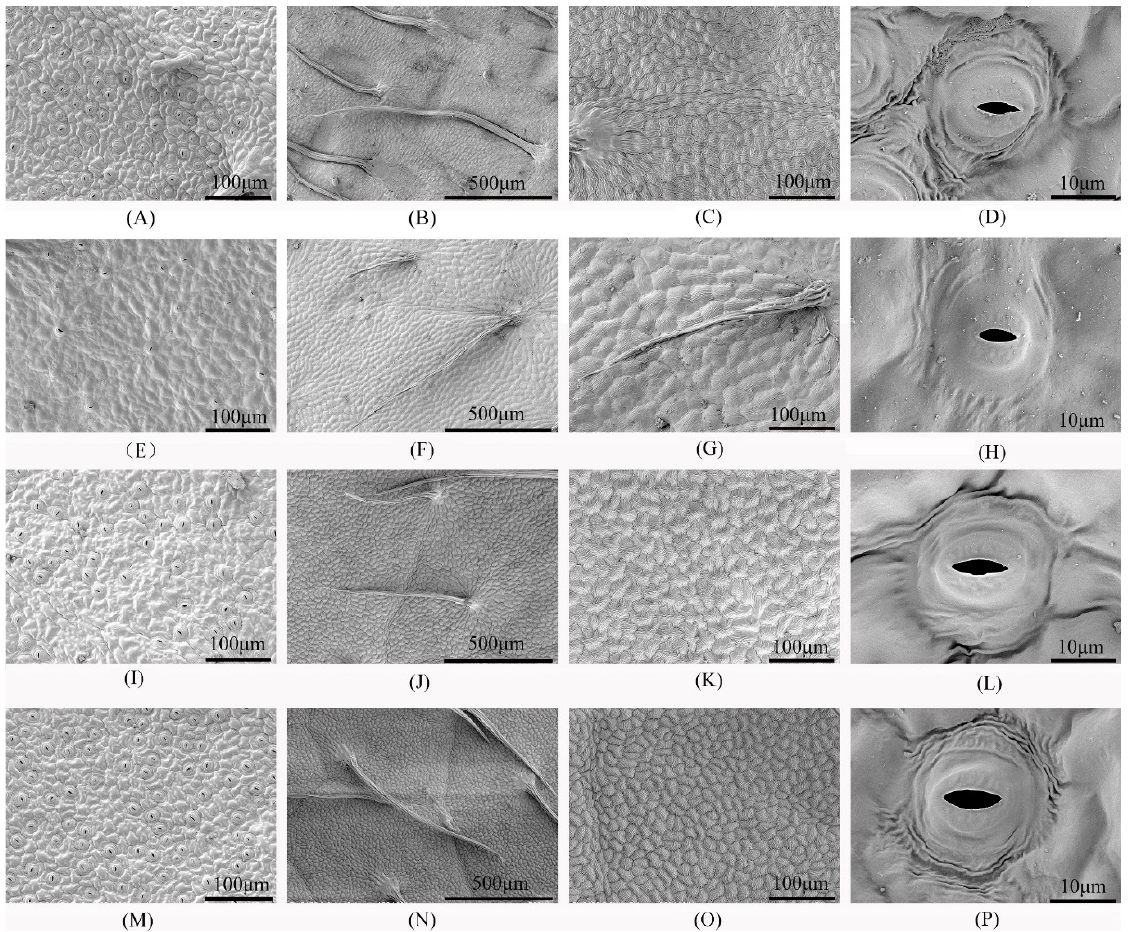
Figure 3. Ultrastructure of leaf epidermal cells of Rhododendron × pulchrum leaves under four treatments. ( A – D ) CK + W represents the control treatment with distilled water; ( E – H ) H + W represents the heat stress treatment with distilled water; ( I – L ) CK + Ca 2+ represents the control treatment with 10 mM CaCl 2 ; ( M – P ) H + Ca 2+ represents the heat stress treatment with 10 mM CaCl 2 ; ( A , E , I , M ) show the stomatal density in the lower epidermis; ( B , C , F , G , J , K , N , O ) show the cell density in the upper epidermis; ( D , H , L , P ) show the stomatal aperture in the lower